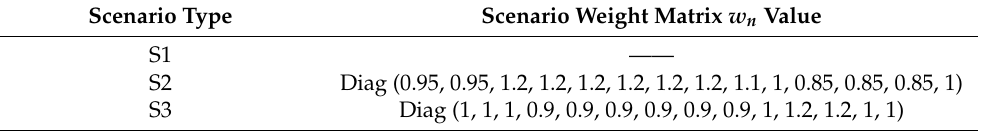
Table 4. Scenario weighting matrix.